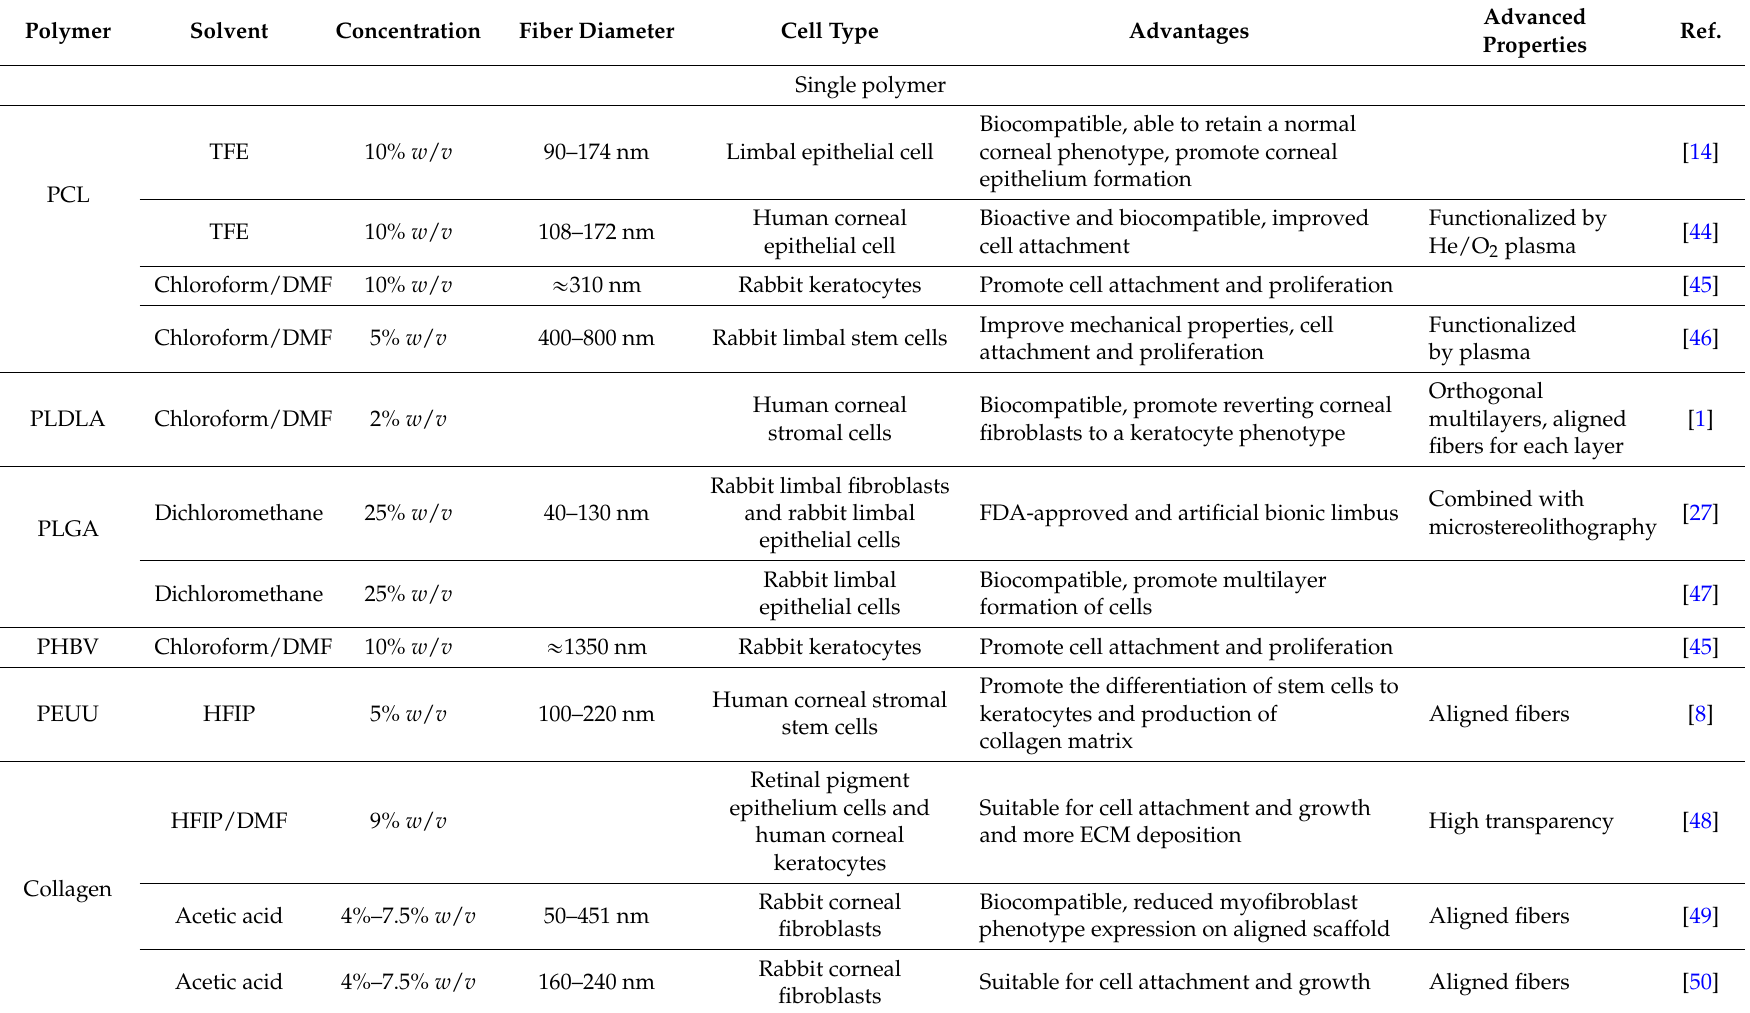
Table 1. The polymers used for fabricating electrospun scaffolds for corneal tissue engineering